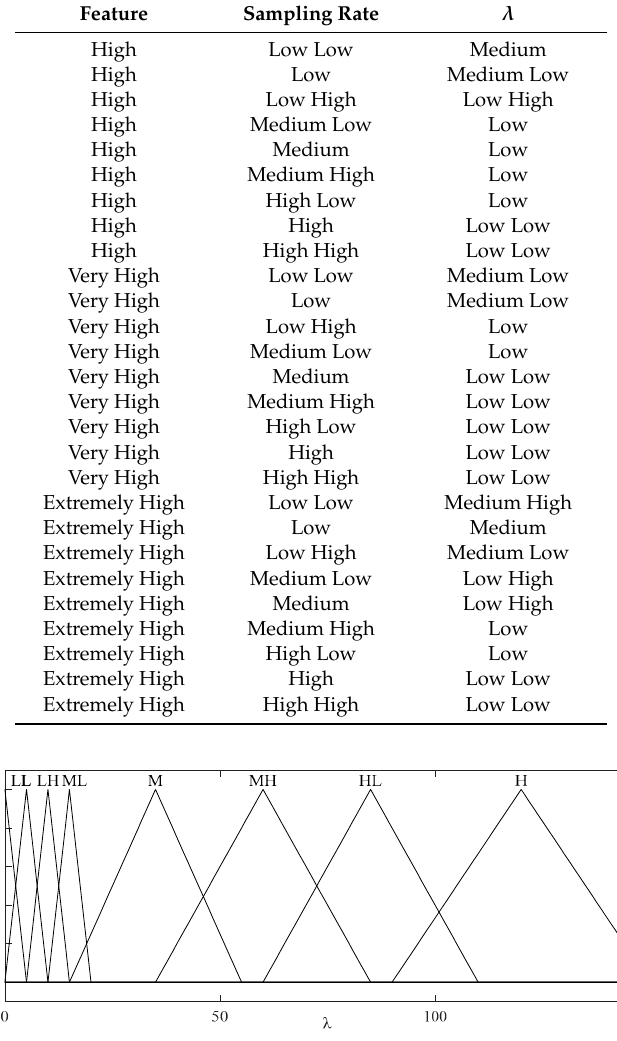
Figure 9. The fuzzy output for λ . (LL = Low Low, L = Low, LH = Low High, ML = Medium Low, M = Medium, MH = Medium High, HL = High Low, H = High)